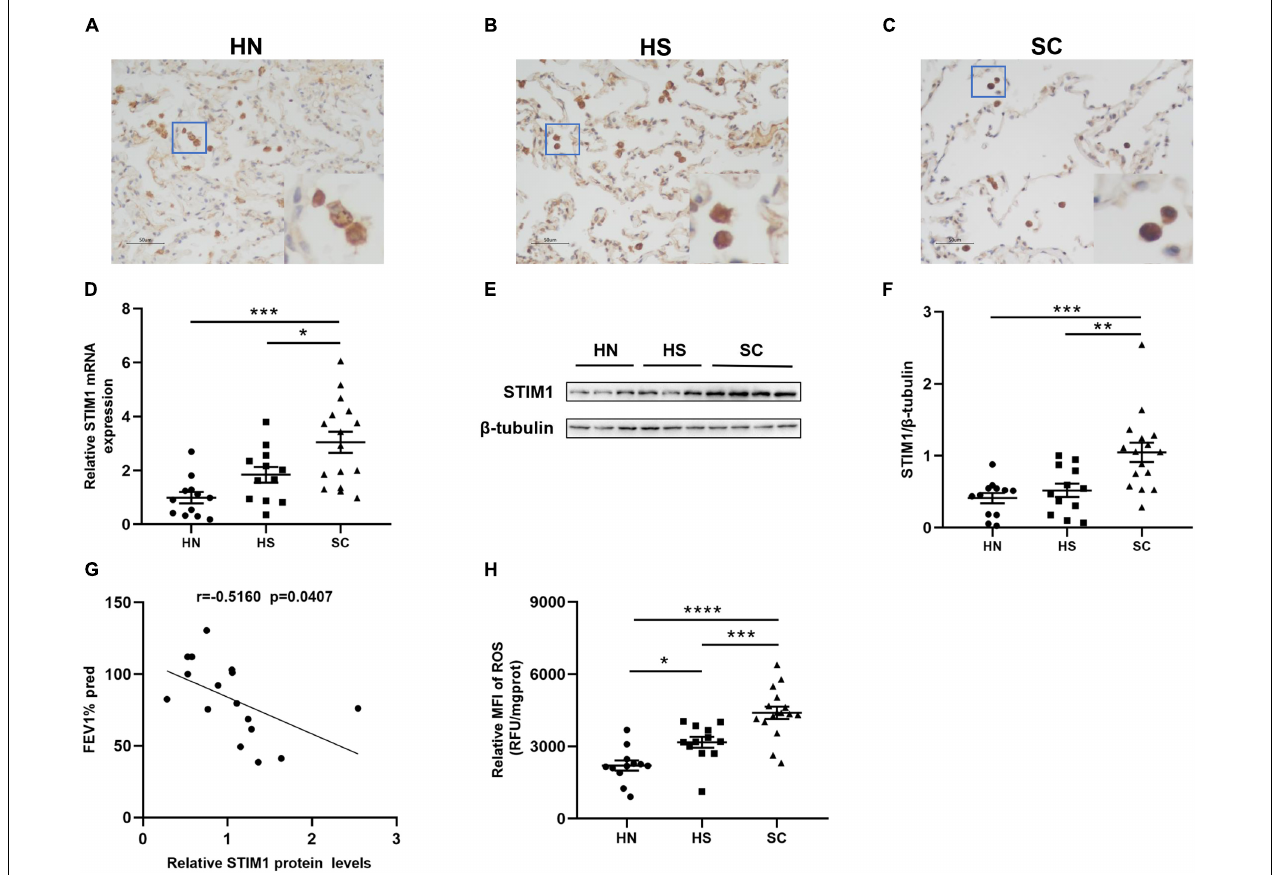
FIGURE 1 | Intrapulmonary stromal interaction molecule 1 (STIM1) expression and reactive oxygen species (ROS) levels are enhanced in the lung of chronic obstructive pulmonary disease (COPD) patients. Representative immunohistochemical images of human lung tissues against STIM1 are shown. Compared with healthy non-smokers (HN) (A) and healthy smokers (HS) (B) , STIM1 expression was markedly increased in the alveolar macrophages of smokers with COPD (SC) (C) . Magnification = × 200. The red-boxed area indicates a region of higher magnification. The STIM1 mRNA expression was increased in SC relative to HN and HS (D) . Representative STIM1 expression in whole-lung tissue homogenates was detected by Western blot (E) and quantified using ImageJ (F) . Increased STIM1 is negatively associated with pulmonary function in COPD patients (G) . The ROS levels of lung tissue in SC patients were significantly increased relative to HS and HN (H) . Data are displayed as mean ± SEM, n = 12 for HN, n = 12 for HS, and n = 16 for SC. P -values were calculated using one-way ANOVA followed by Newman–Keuls test. * P < 0.05, ** P < 0.01, *** P < 0.001, and **** P < 0.0001 represent significant differences. STIM1, stromal interaction molecule 1; FEV1%pred, forced expiratory volume in 1 s (FEV1)% predicted; ROS, reactive oxygen species; MFI, Mean fluorescent intensity; HN, healthy non-smoker; HS, healthy smoker; and SC, smoker with